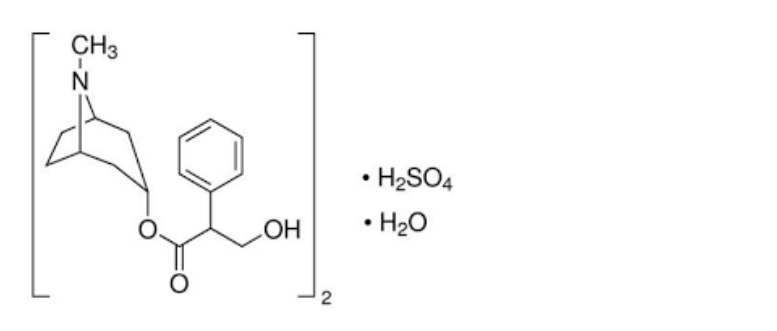
Figure 1. The chemical structure of atropine sulfate.